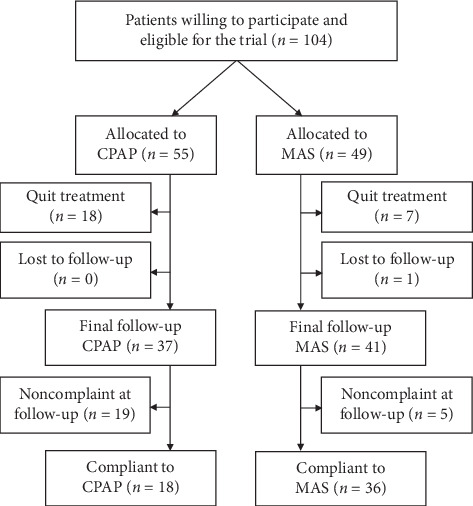
Patient flowchart.